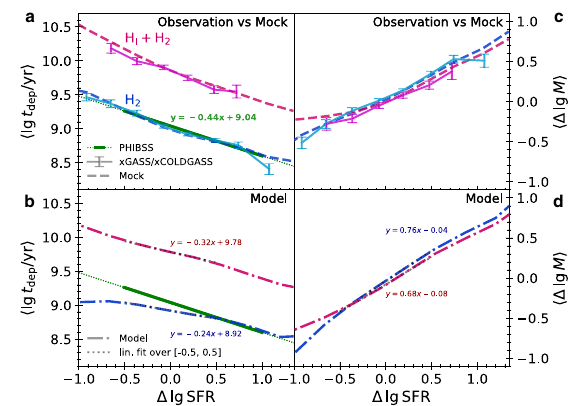
Fig. 4 Scaling of depletion times and gas masses. a Average depletion times in the extended xGASS/xCOLD GASS sample of M star ~ 10 9 − 10 11 M ⊙ nearby galaxies (solid lines with error bars) and in a mock sample with the same stellar mass distribution (dashed lines) showing good agreement. Blue/cyan lines (red/magenta lines) refer to molecular gas (to the sum of molecular and neutral gas including Helium). Galaxies with undetected or missing star formation rates (SFRs) are excluded from the analysis. Error Fig. 3 Projection of the star-forming plane along the H I direction. bars correspond to standard errors of the bin averages. The solid green line ) in a Distribution of star formation rate (SFR) and molecular gas mass ( M H 2 shows the fi t of the H 2 depletion time from the PHIBSS survey 10 covering the representative xGASS/xCOLD GASS sample for galaxies with M star = z = 0 – 4 (dotted lines are extrapolations). b The scaling of the actual 10 10±0.3 M ⊙ (blue dots with 1 − σ uncertainty contours) and isocontours of depletion times, i.e., if measured without observational errors and detection the probability density of galaxies with the same stellar mass range limits, for the galaxies in the mock sample. Galaxies with zero SFRs are according to the fi ducial model (dashed lines include 68 and 95% of excluded from the analysis. For typical offsets from the star-forming galaxies in the continuous component). Solid lines show the corresponding sequence, the molecular gas depletion time shows only a mild dependence contours for a mock sample based on the fi ducial model with observational ( ∝ SFR − 0.24 ) on SFR. c , d Same as a , b but showing the average change in errors and detection limits added. Observational data with missing SFRs gas masses relative to the peak position of the corresponding gas sequence (molecular gas masses) are shown as magenta (green) circles at the with offset from the star-forming sequence. The peak position of the total bottom (left) edge of ( a ). Censored observational data are omitted for gas sequence is given by the sum of the peak positions of the molecular and clarity of presentation. The red star indicates the peak position of the star- neutral gas sequences including Helium. Changes in star formation activity forming sequence and the molecular gas sequence for galaxies with M = 10 10 M fi ducial model. b , c Marginal probability of typical starforming galaxies are tightly linked to changes in their ⊙ according to the star molecular and total gas density functions (pdf) of the xGASS/xCOLD GASS sample (blue histograms), the mock sample (yellow histograms), and the fi ducial model (dashed curves) for M star = 10 10±0.3 M ⊙ galaxies. d Number of M star = 10 10±0.3 M ⊙ galaxies in the representative xGASS/xCOLD GASS sample with measured ('meas'), missing ('miss'), and undetected ('cen') SFR and/ or M H values. While the mock sample reproduces the observational data 2 well, the differences between the mock data and the true model predictions suggest that signi fi cant biases can be introduced by censored, missing, and uncertain data.